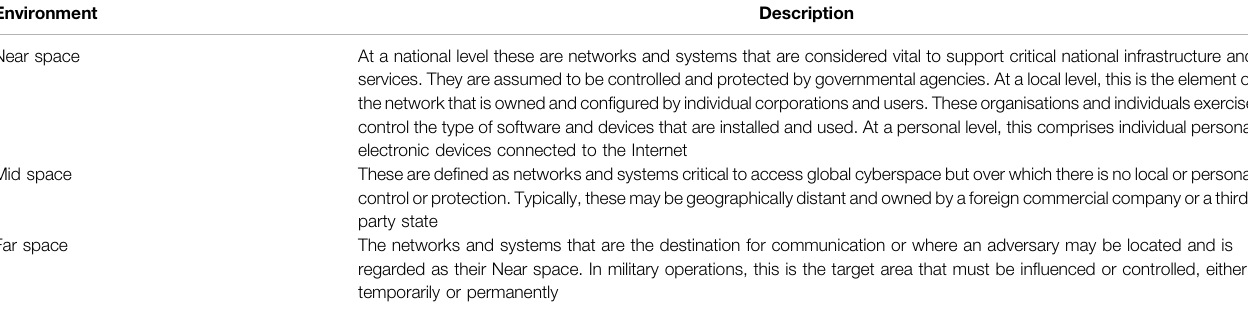
TABLE 2 | Adding a notion of distance to cyberspace. Environment